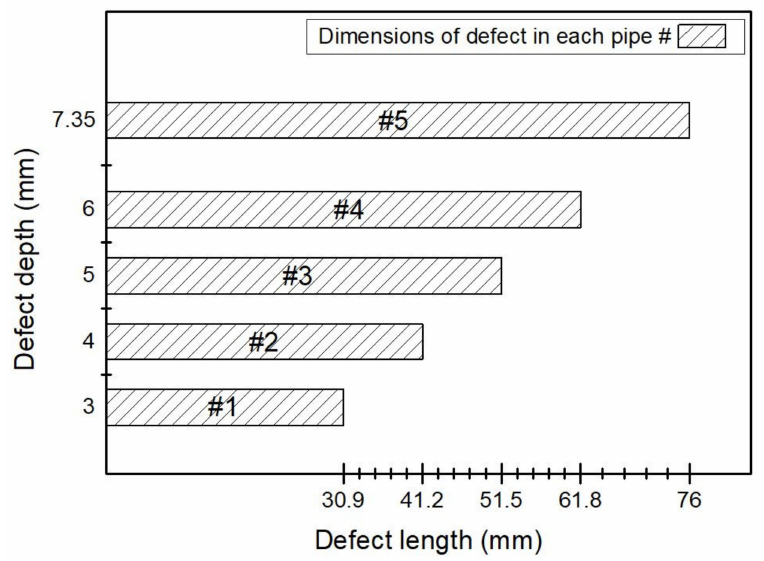
Figure 3. Dimension of the circumferential defect in each